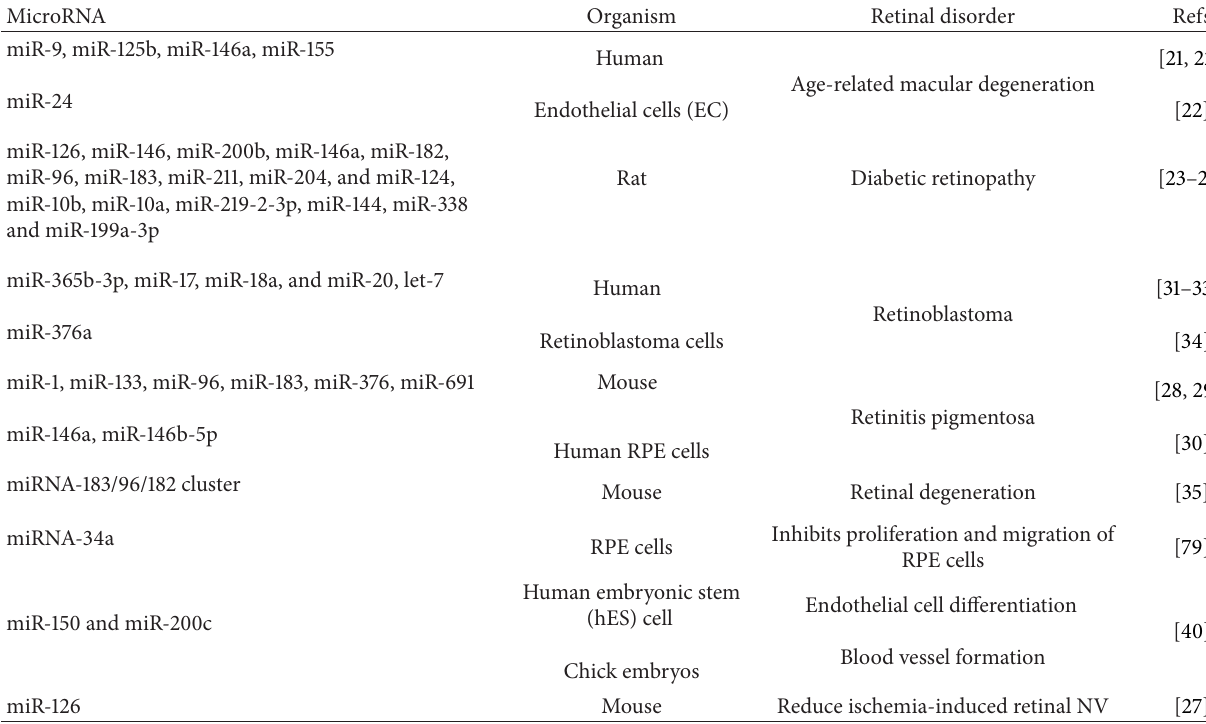
Table 1: Differentially expressed microRNAs in retina related disorders in human and animal